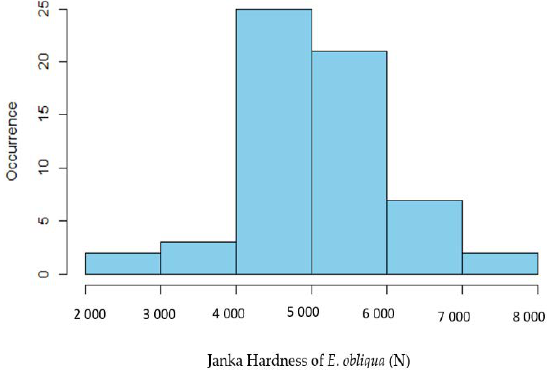
Figure 4. Distribution of Janka hardness results for E. obliqua .